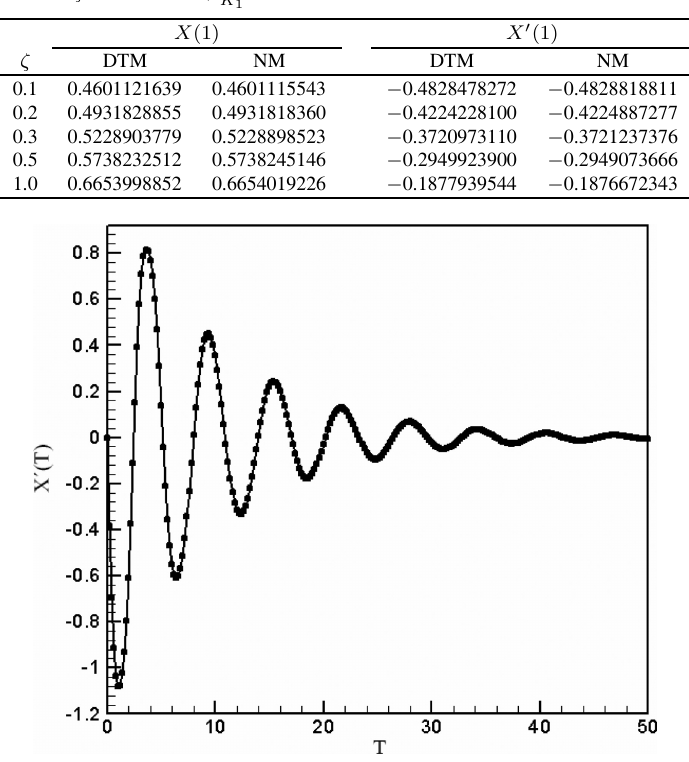
= 1 , Ω = 0 . 75 and P = 0 which 1